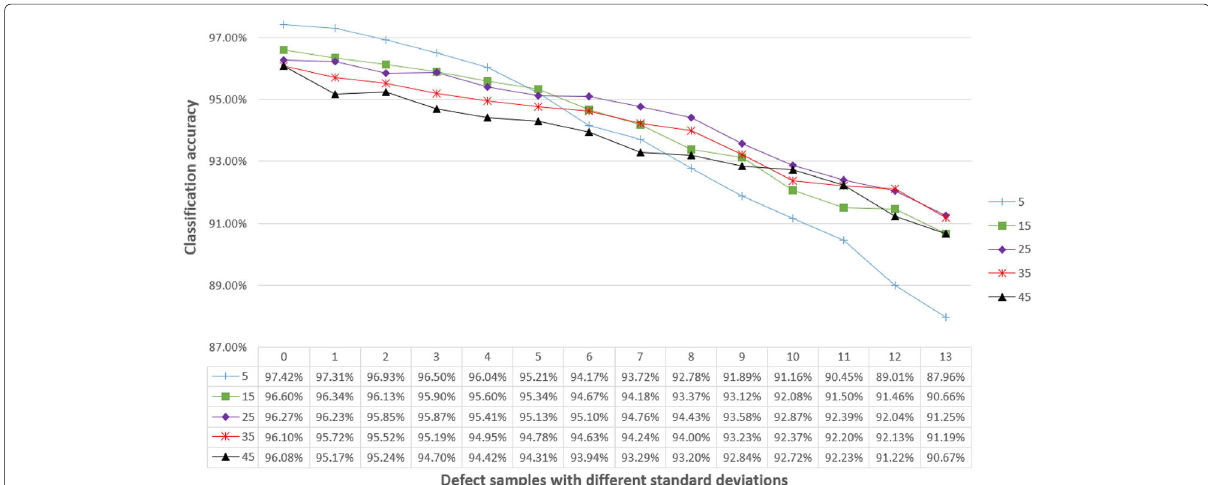
Fig. 9 Accuracy of BYEC classifiers with different k values (5, 15, 25, 35, and 45) on the defect samples with different standard deviations ( 0 − 13